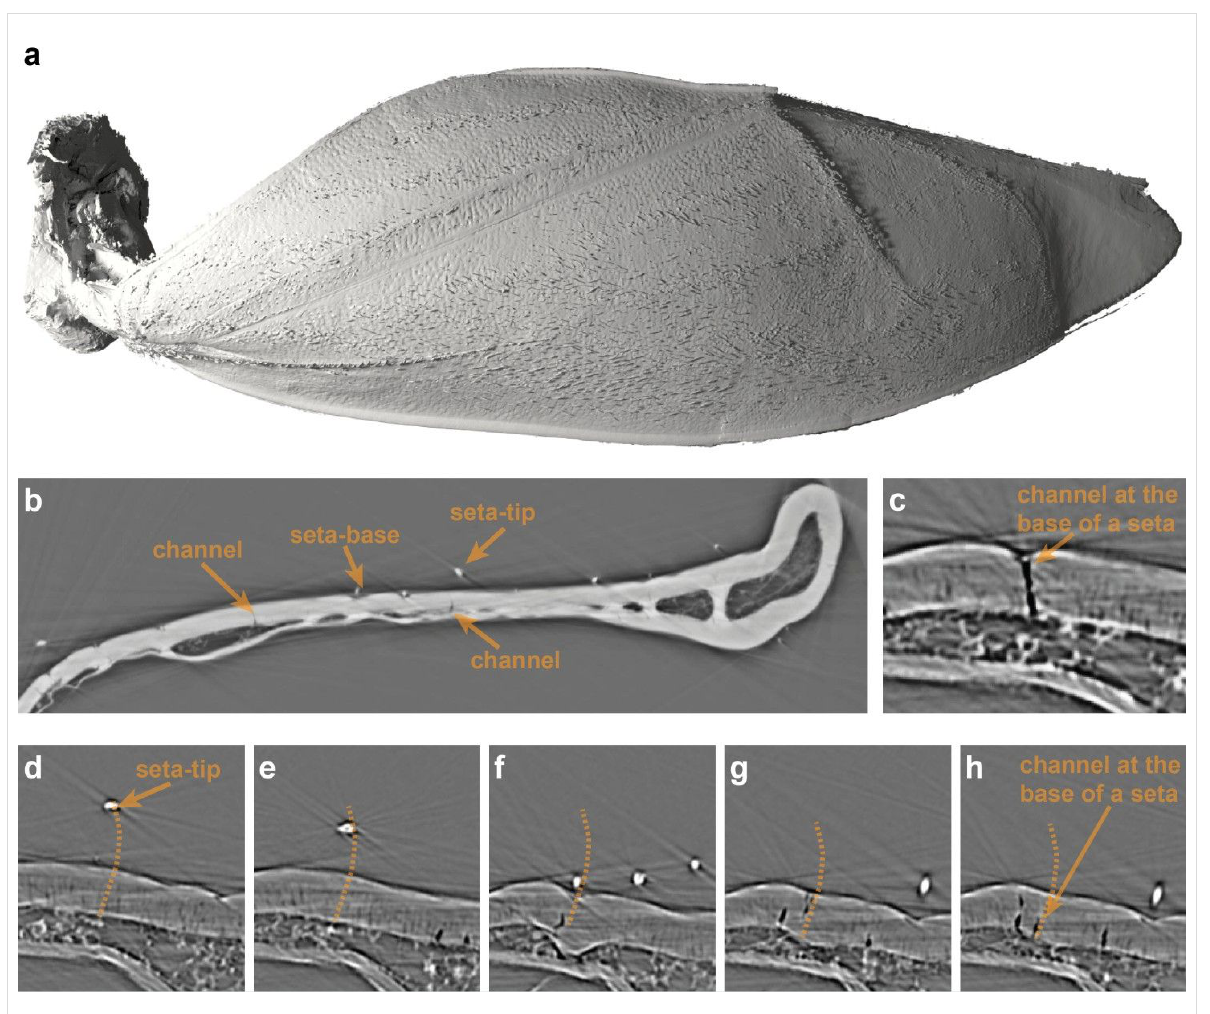
Figure 4: a) Three-dimensional reconstruction of a hemelytron µCT scan. The tomography data allowed an analysis of the outer and inner structures of the hemelytron. b) Digital cross section through a SR-µCT scan of a hemelytron. c) Part of the cross section, where the dendritic canal below the setal base is visible, indicating an innervation of the seta. d–h) A stack of µCT-images used for tracking single seta and identifying the corresponding setal base and setal tip.